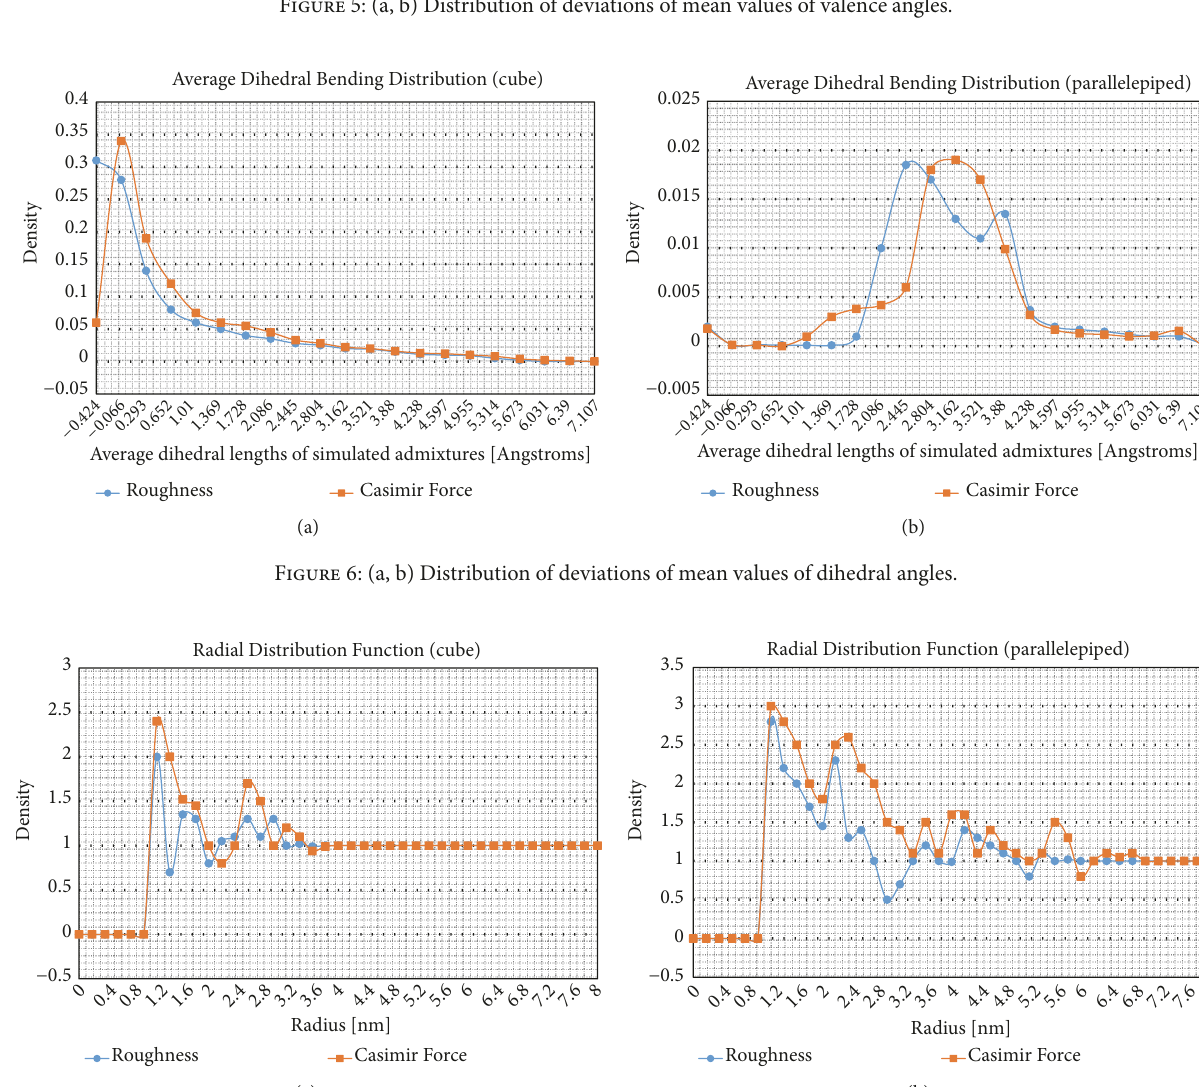
Figure 5: (a, b) Distribution of deviations of mean values of valence angles.